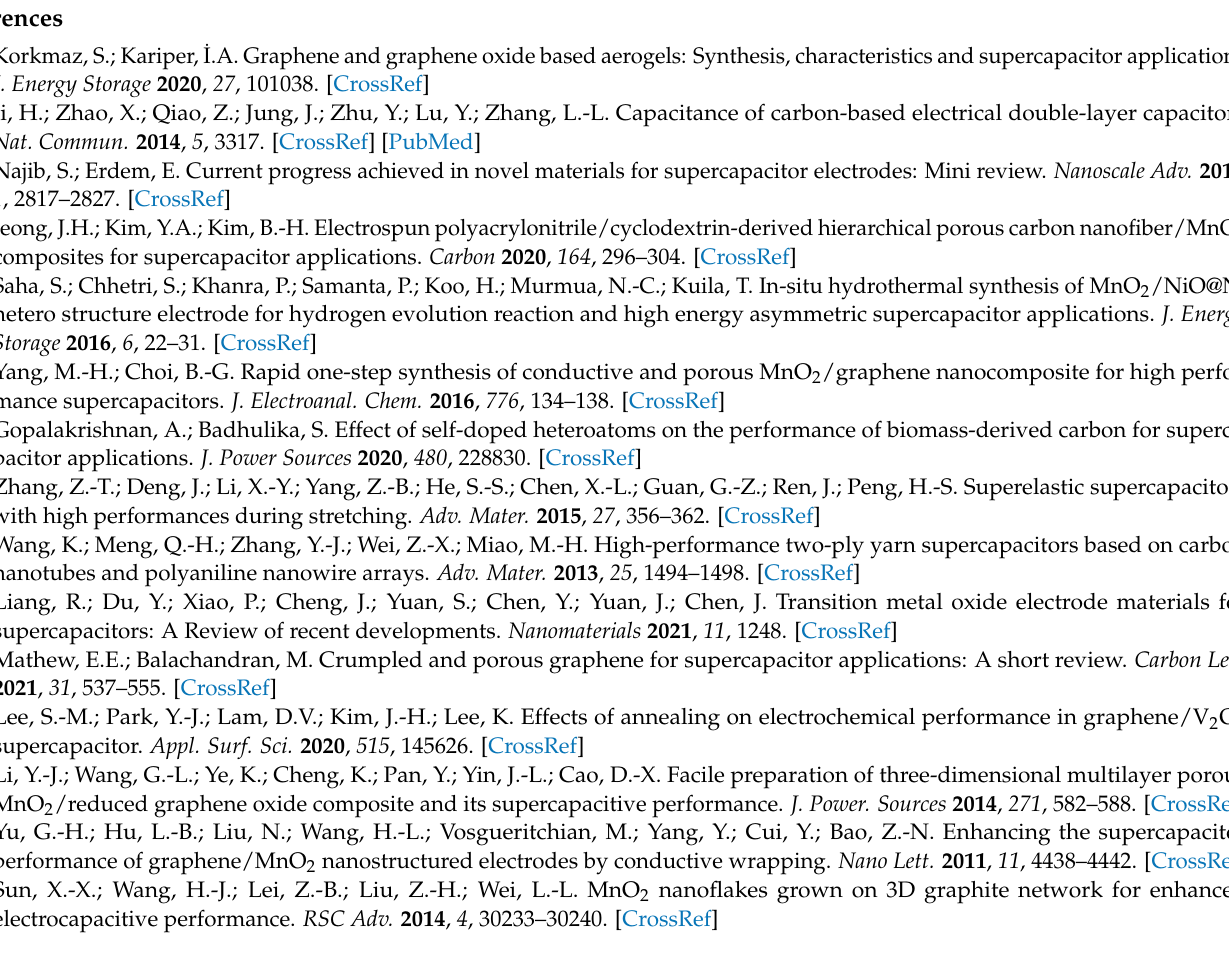
MnO 2 /graphene materials, Table S4: A comparison of the energy density and power density for the MnO 2 //carbon system asymmetric supercapacitor in this work with the literature, Figure S1: (a) CV curves of 0.12 mg loaded graphene/Ni at different scan rates; (b) CV curves of MnO 2 , MnO 2 /graphene/Ni and graphene/Ni (Ni: 54.35 mg, MnO 2 : 0.09 mg, and graphene: 0.12 mg), Figure S2: The Raman spectra of as–produced graphene, Figure S3: The TEM analysis for the as- obtained MaO 2 (a) and MnO 2 /graphene material (b), Figure S4: The CV characteristic curves of blank Ni foam at different scan rates, Figure S5: The GCD test for MnO 2 /graphene/Ni electrodes obtained from different electrodeposition current densities examined at 1 A g − 1 , Figure S6: BET specific surface area and pore size distribution analysis for MnO 2 and MnO 2 /graphene